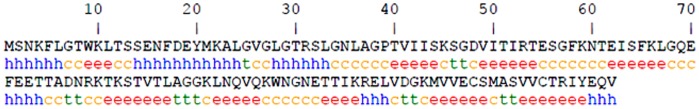
Secondary structure of EULP.Secondary structure of 14.5 kDa protein was analyzed by SOPMA tool. The total sequence length was 132 and the sequence contains extended strand (Ee), alpha helix (Hh), random coil (Cc) and beta turn (Tt).